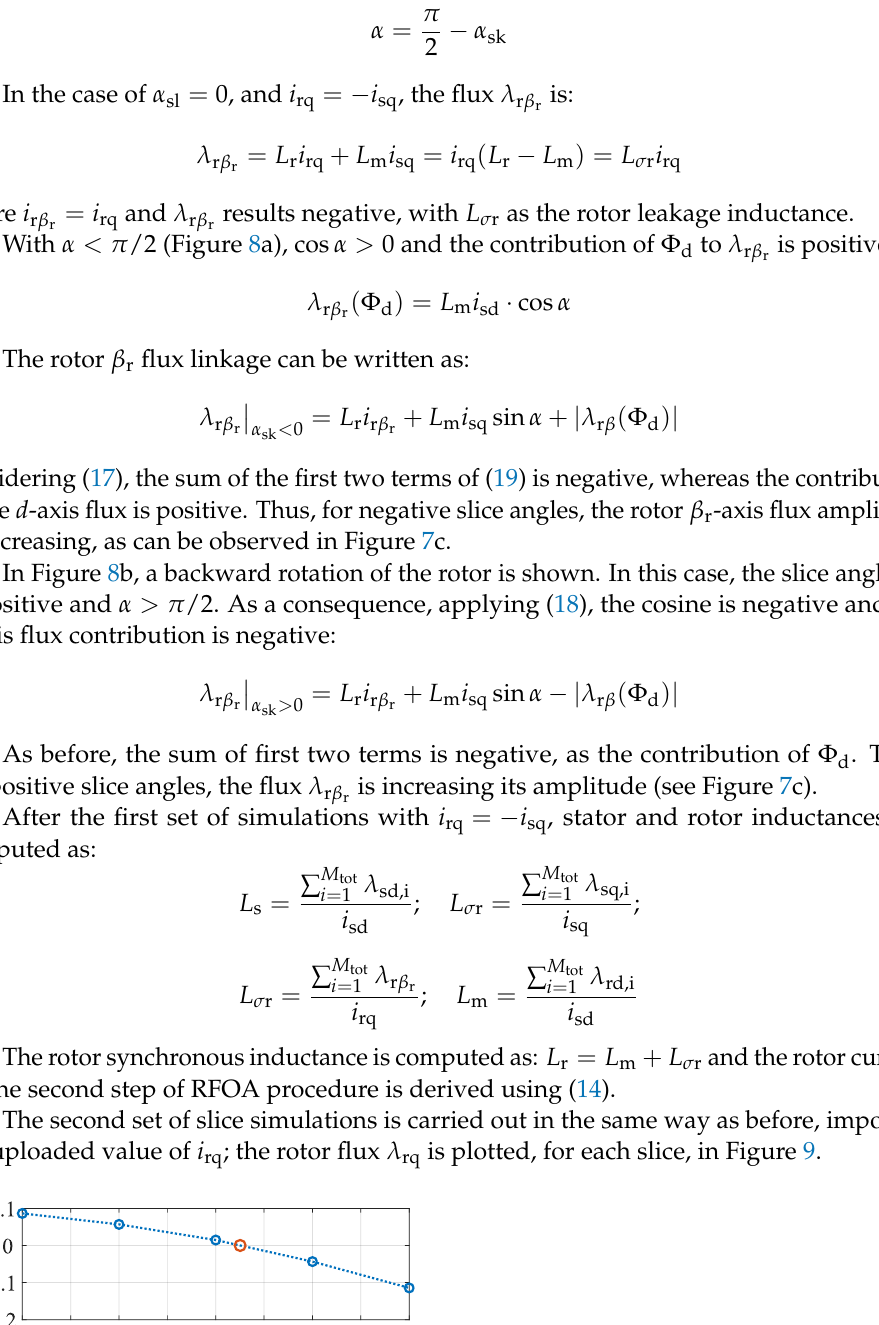
for each slice) for each considered slice, r